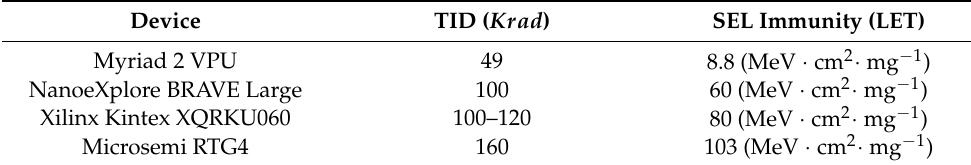
Table 7. Radiation performance for Myriad 2 and rad-hard